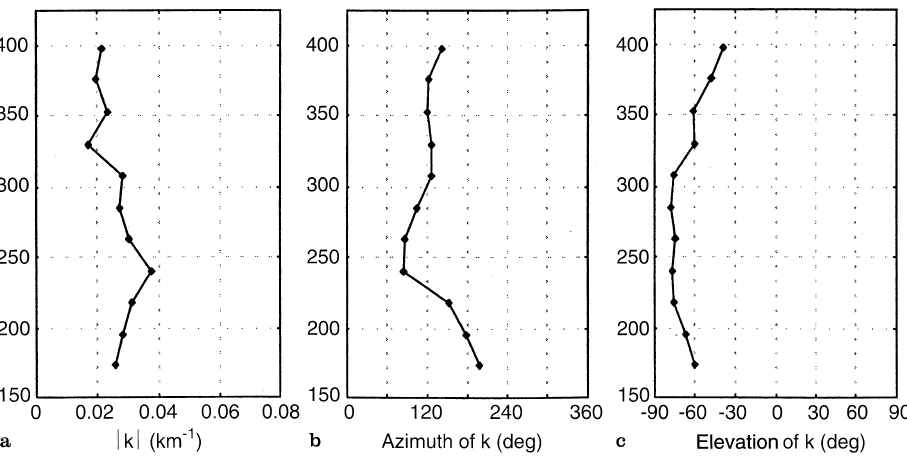
Fig. 6a–c. Height profile of the apparent wave vector, k , of the N e -TID for a period of about 72min. a Magnitude of k ; b azimuth of k with north and east direction as positive; c elevation angle of k with upward direction